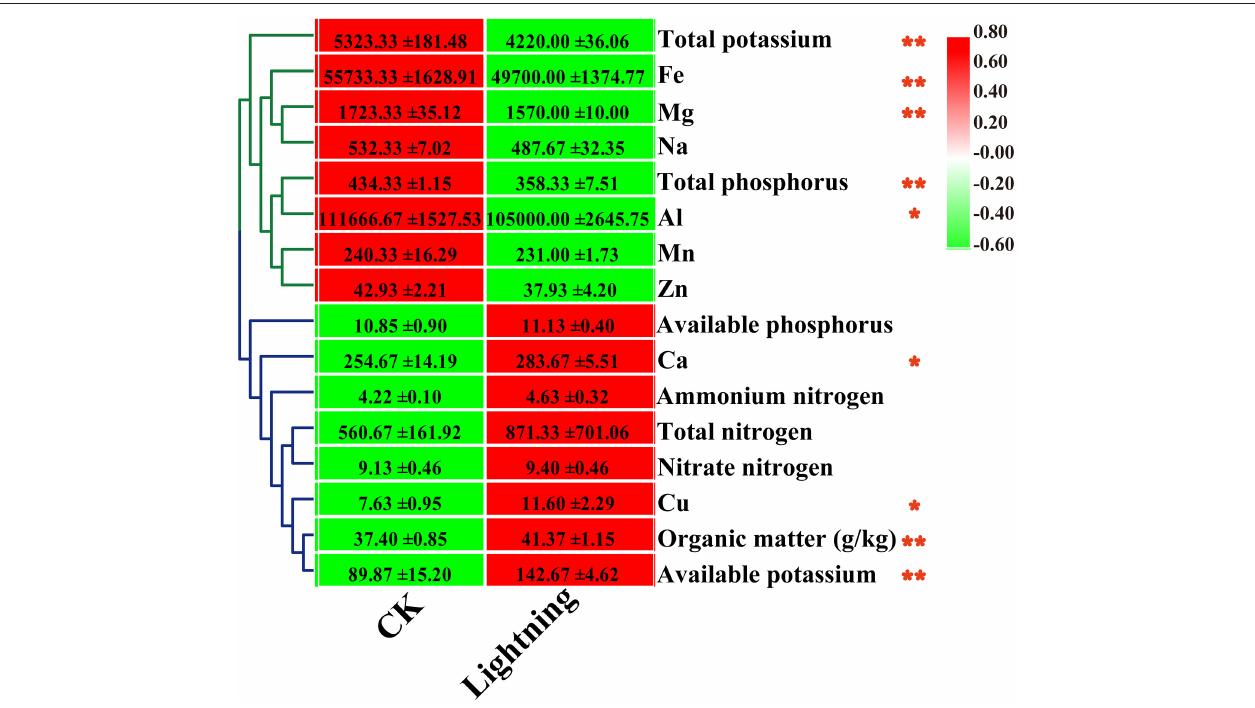
FIGURE 1 | Heat map of rhizosphere soil properties of Pu-erh tea. The contents of different elements are expressed as mean values ± standard deviation (SD) (mg/kg). Lighting represents a sample 10m from the lightning rod; CK indicates that the distance between the sample and the lightning rod is > 1,500m. *Indicates significant differences between different samples at the level of P < 0.05, while **Indicates significant differences between different samples at the level of P <